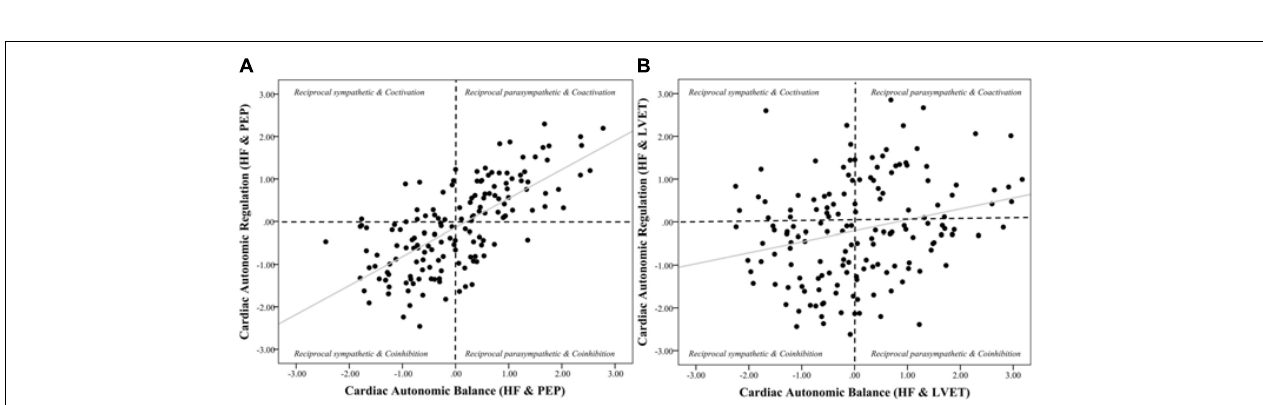
FIGURE 3 | Scatterplots of cardiac autonomic balance and regulation computed using HF-HRV and both PEP and LVET. Note. ( A ) depicts the strong significant association between cardiac autonomic balance (CAB) and regulation (CAR) calculated using high frequency heart rate variability (HF) and pre-ejection periods (PEP) ( r = 0.69, p < 0.001). ( B ) depicts a significantly weaker association between CAB and CAR calculated using left ventricular ejection time (LVET) ( r = 0.26, p < 0.001). The correlation coefficient between CAR and CAB computed using PEP was significantly stronger than when computed using LVET ( z = 5.12, p < 0.001).